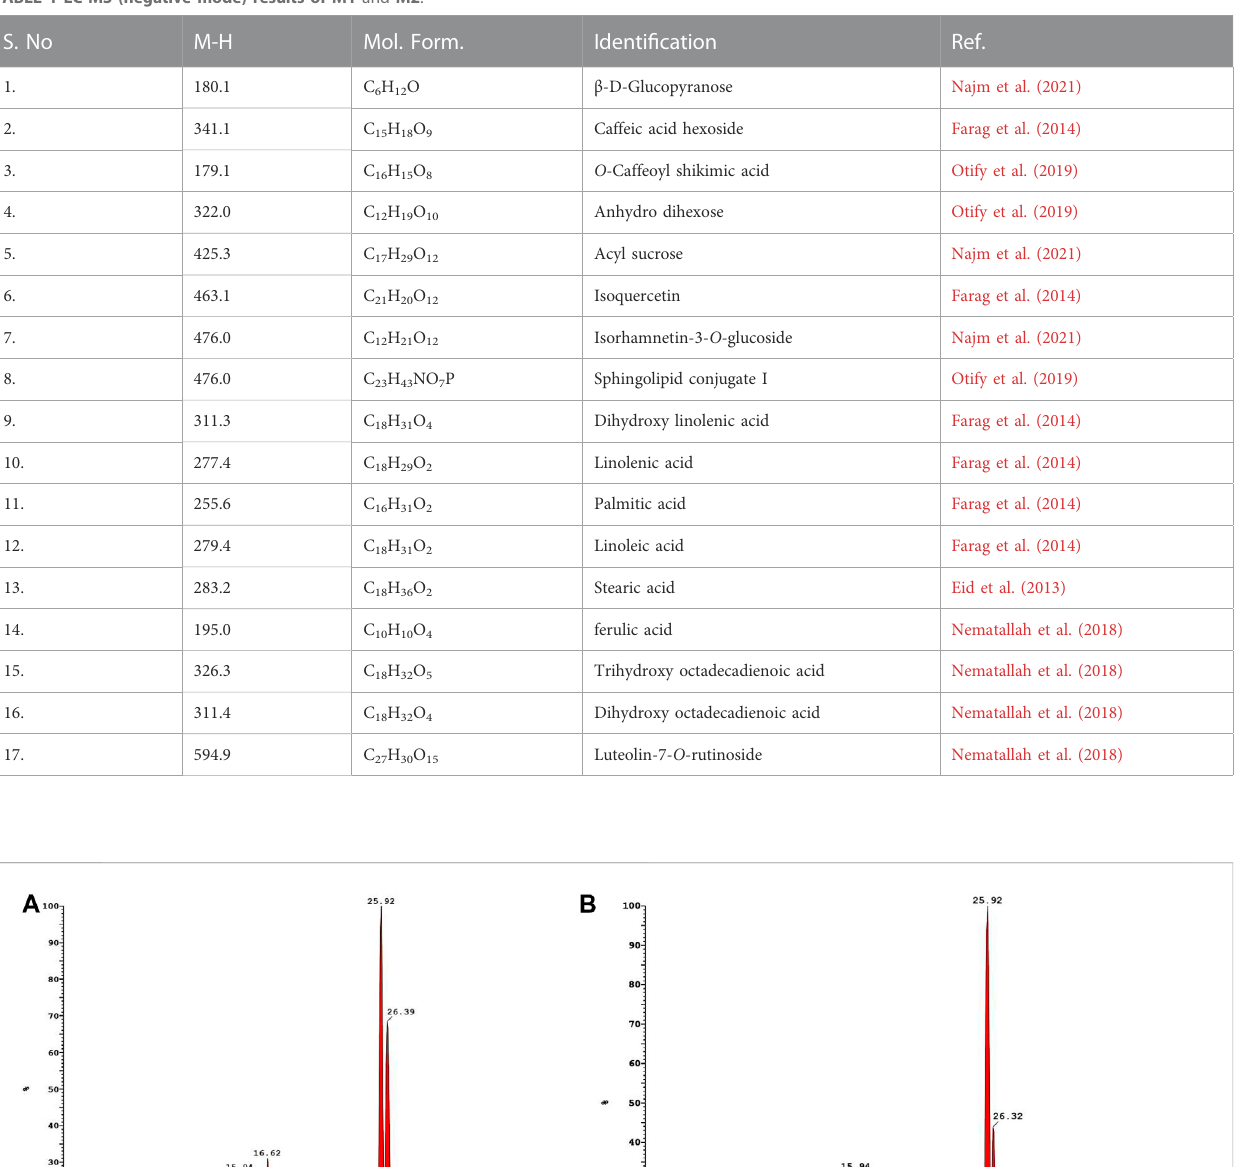
TABLE 1 LC-MS (negative mode) results of M1 and M2 .